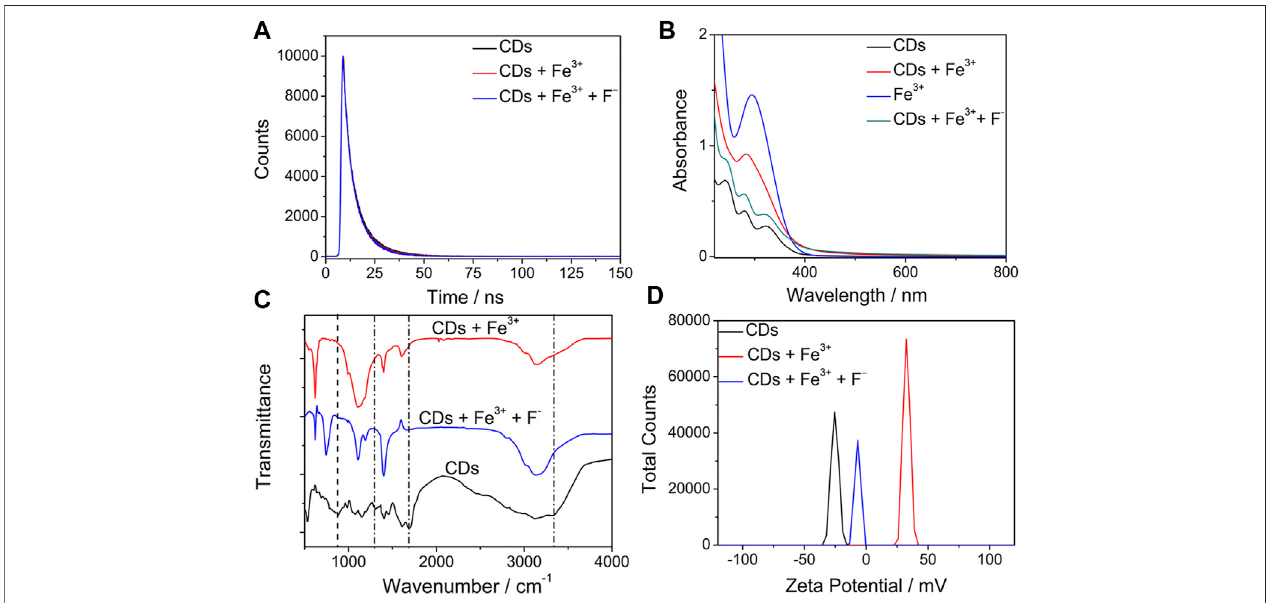
FIGURE 4 | (A) Fluorescence decay curves of the N/P CDs (10 μ g · mL − 1 ) with and without Fe 3+ (40 μ M) and F − (30 μ M). (B) UV − vis spectra of Fe 3+ , N/P CDs, and N/P CDs in the absence and presence of Fe 3+ (40 μ M) and F − (30 μ M). (C) FTIR spectra and (D) ζ potential of the N/P CDs (10 μ g · mL − 1 ) with and without Fe 3+ (40 μ M) and F − (30 μ